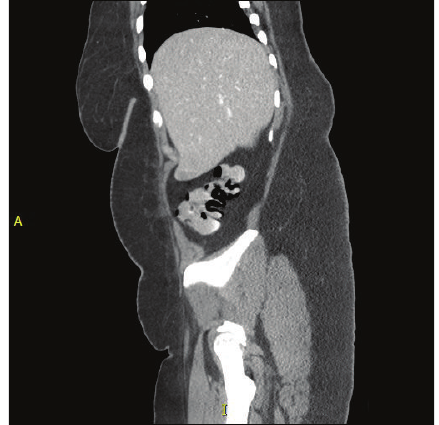
Figure 2: Showing Pneumatosis Intestinalis in right lower quadrant in a sagittal cut of CT imaging.